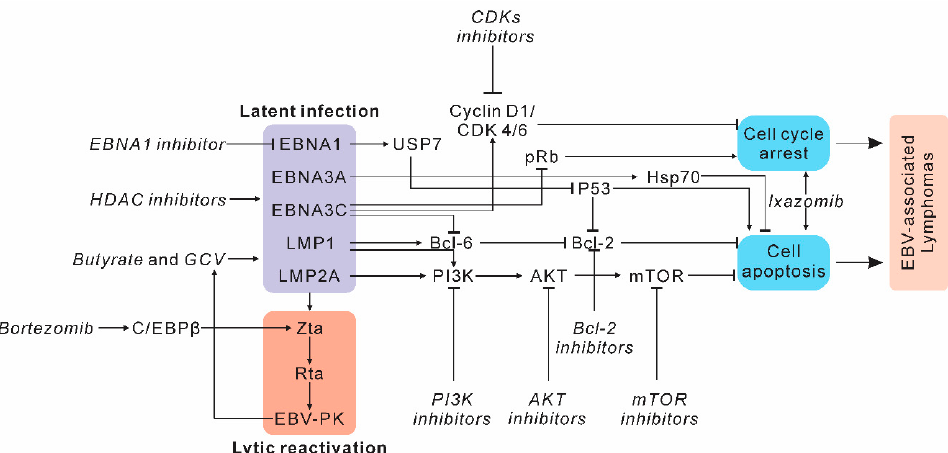
Figure 2. Therapeutic strategies for targeting EBV-associated lymphomagenesis. EBV-expressed latent proteins induce cell cycle arrest and cell apoptosis through the regulation of many crucial signaling pathways during lymphomagenesis. Specific small molecule inhibitors (italic font) that can target the key factors in these pathways are underlined.